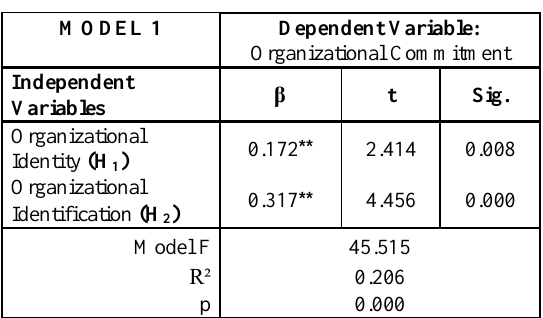
Table 3: The Results of the Regression Analysis for the Relationship between OI, OID and